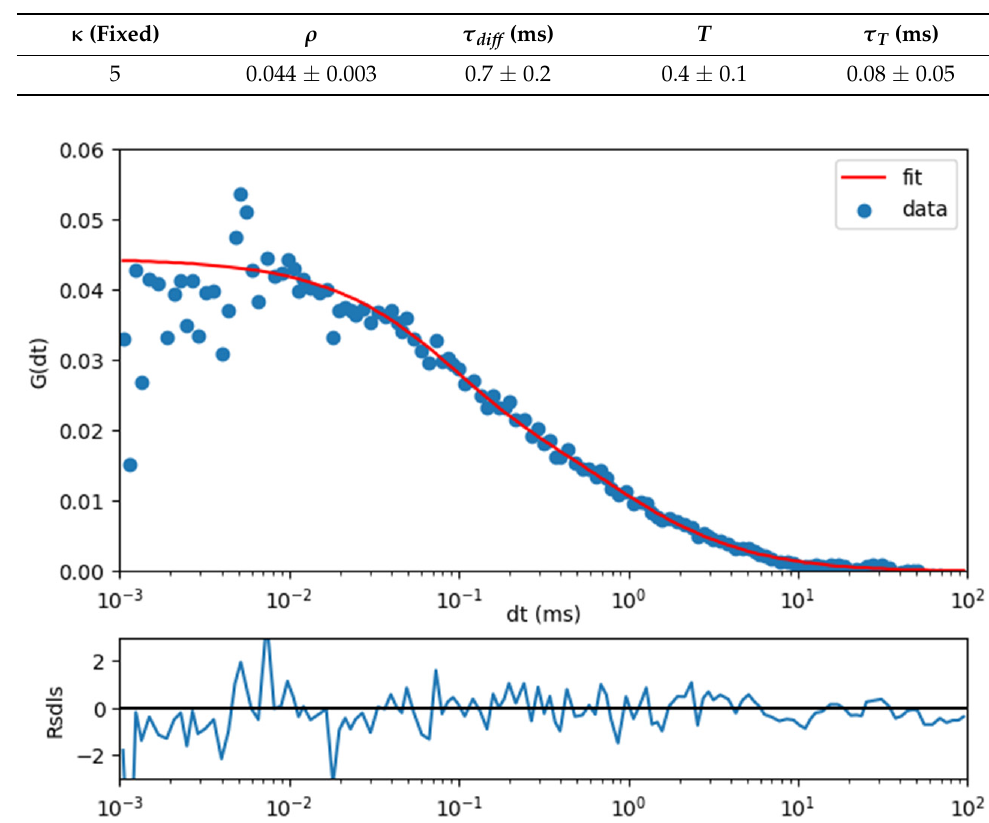
Table 1. Calculated parameters for Equation (1).